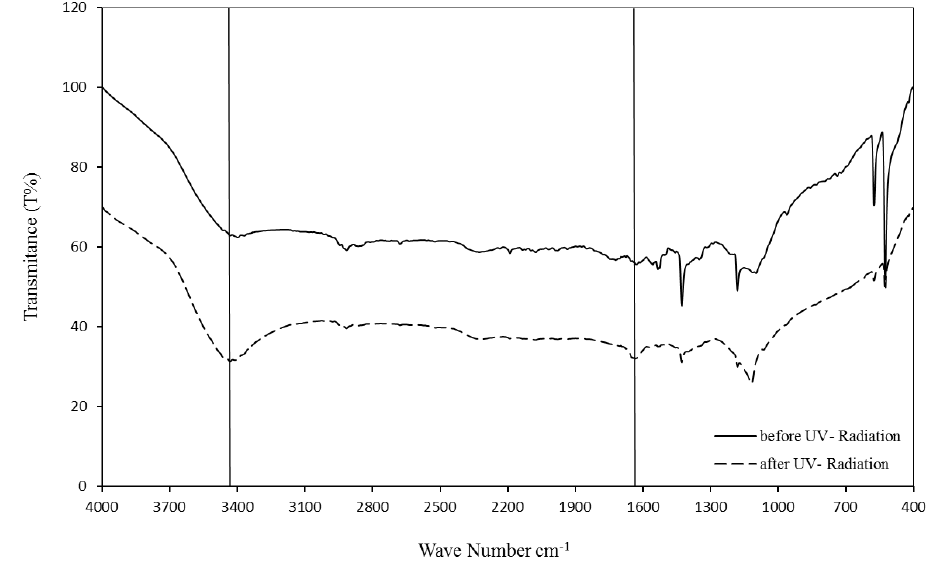
Figure 2. Peaks of −OH and C=O groups are clearer in C UV radiation in strong acids.